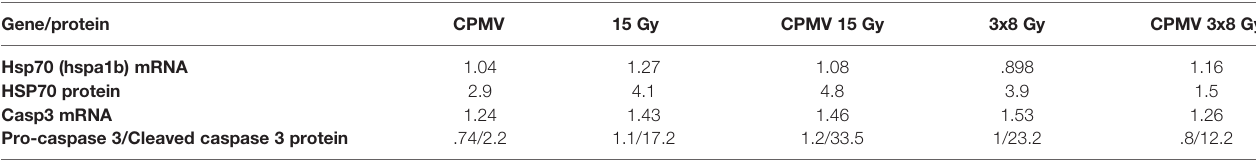
TABLE 2 | Protein & mRNA Expression. Protein & mRNA expression levels (as compared to control) for heat shock protein 70, caspase 3, and cleaved caspase 3. Gene/protein